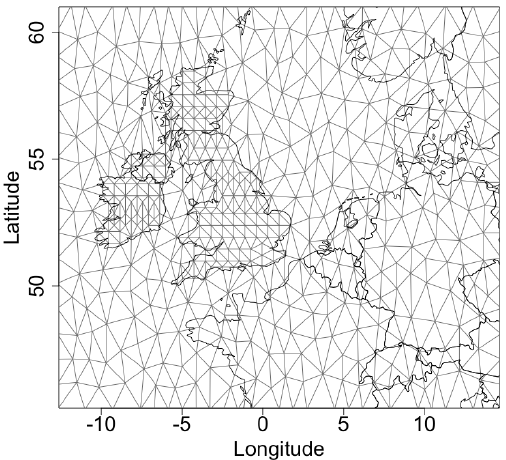
Figure 1. A mesh constructed using constrained refined Delaunay triangulation, where the distribution of nodes is denser around the United Kingdom and